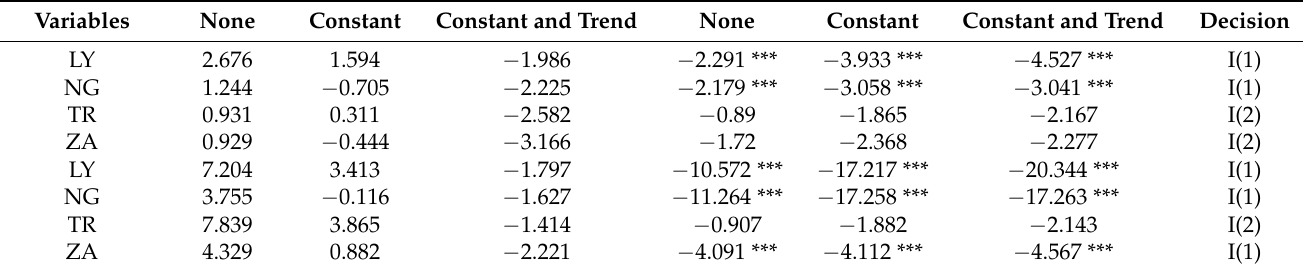
Table 2. ADF and PP unit root test